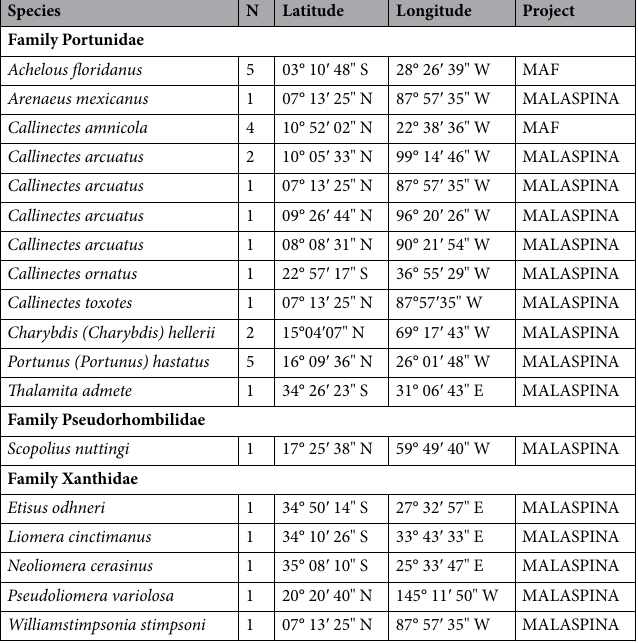
Table 5. Sampling sites (geographical coordinates), project, and number of the megalopas of the species of portunids, pseudorhombilid and xanthids collected in the MALASPINA 2010–2011 and MAF 2015